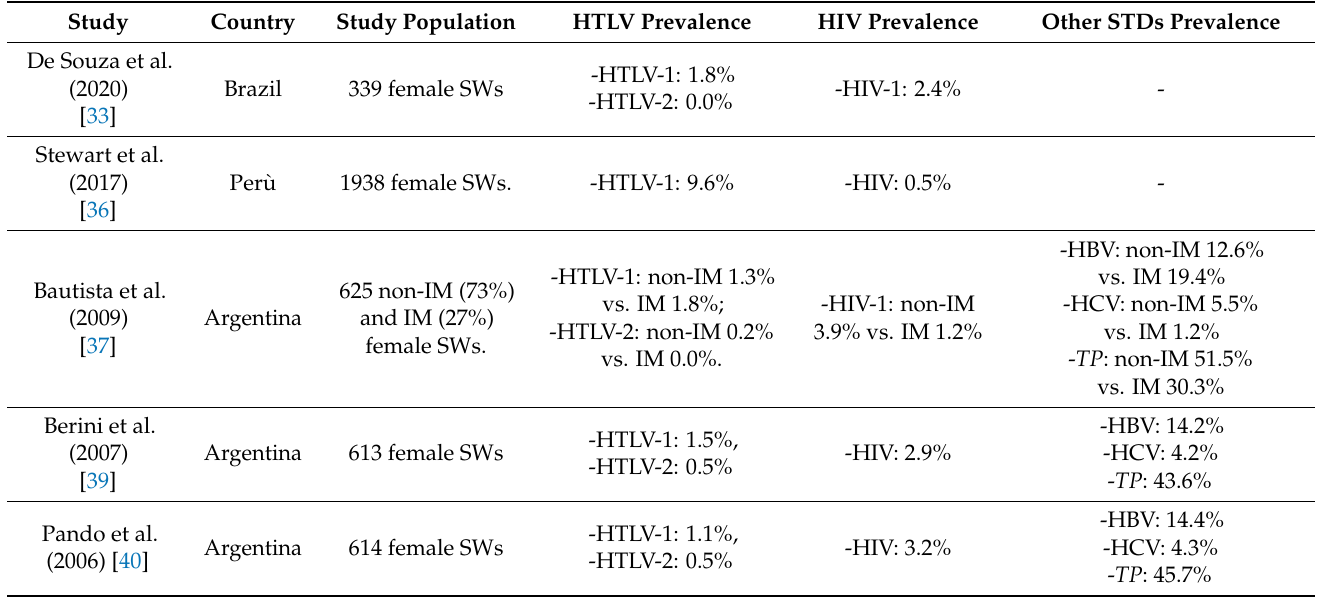
Table 4. Comparison among HTLV and other STDs prevalence in SWs